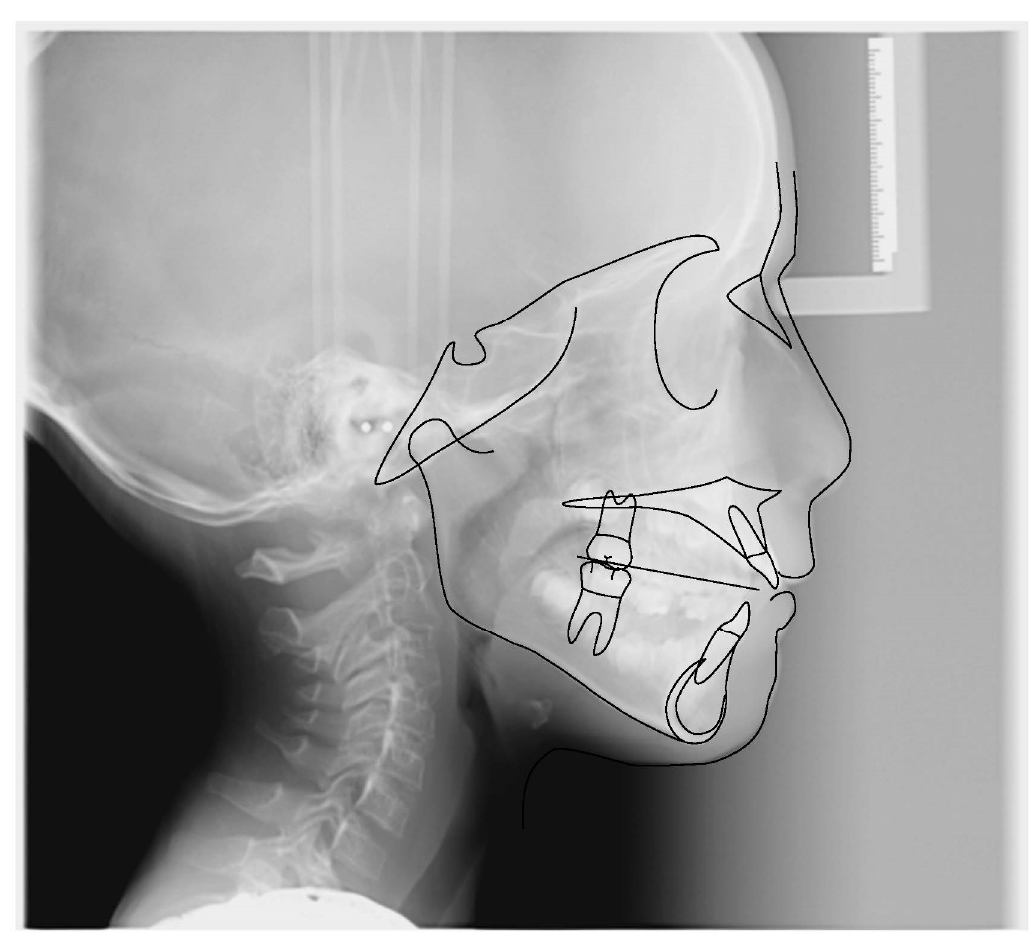
Figure 33. Cephalometric tracing (DeltaDent software) before treatment (8-year-old).